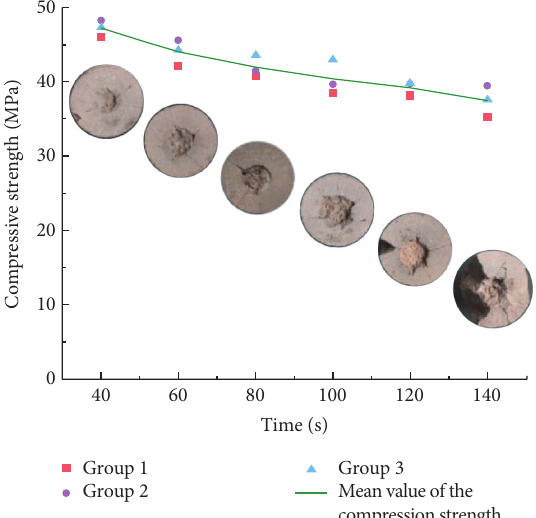
Figure 7: Effect of ultrasonic vibration on the UCS of the rock specimen.